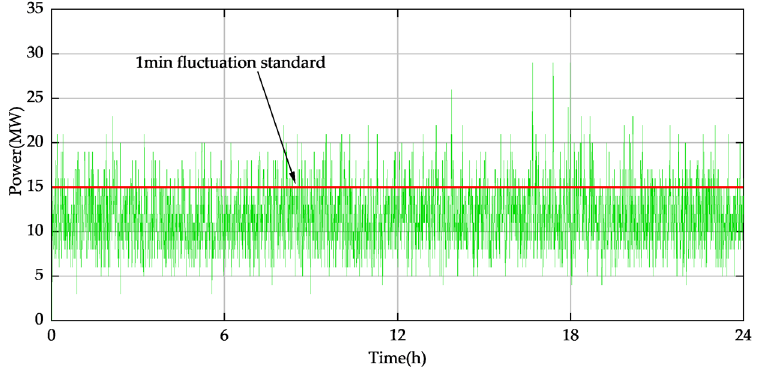
Figure 13. The amount of fluctuation before and after the smoothing of 1 min at a fixed value.